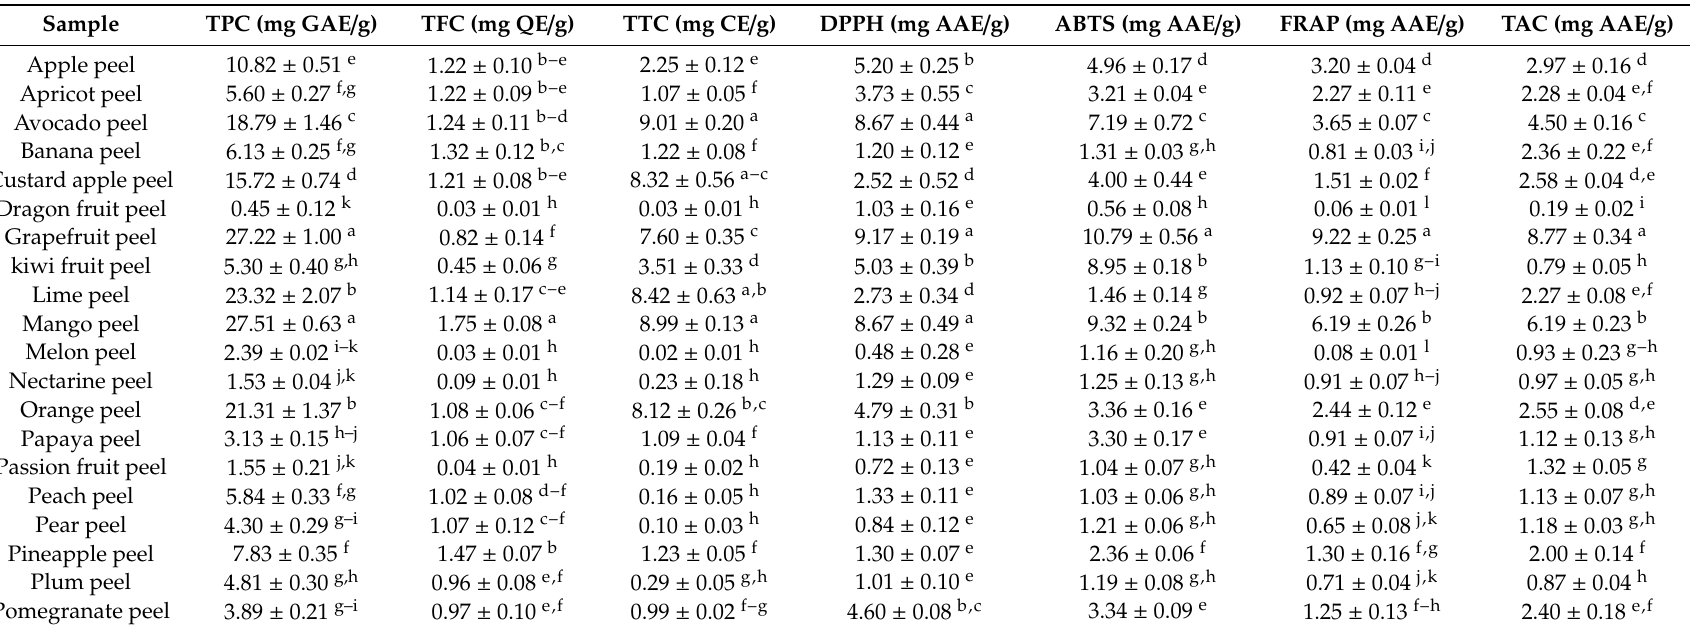
Table 1. The polyphenol concentrations and antioxidant potentials of twenty di ff erent selected fruit